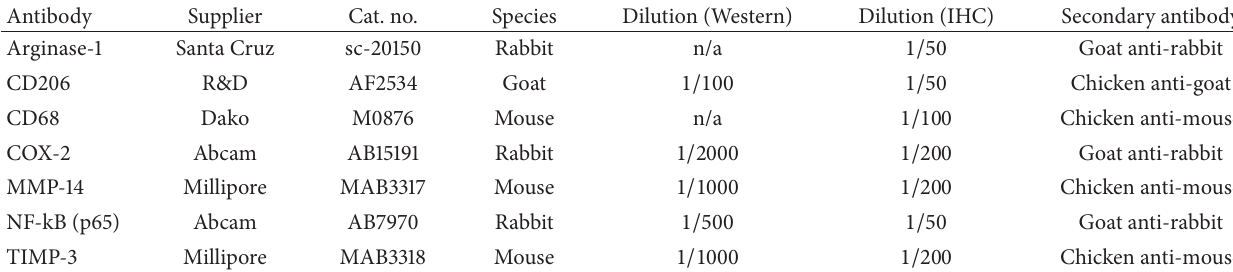
Table 1: Antibodies used for